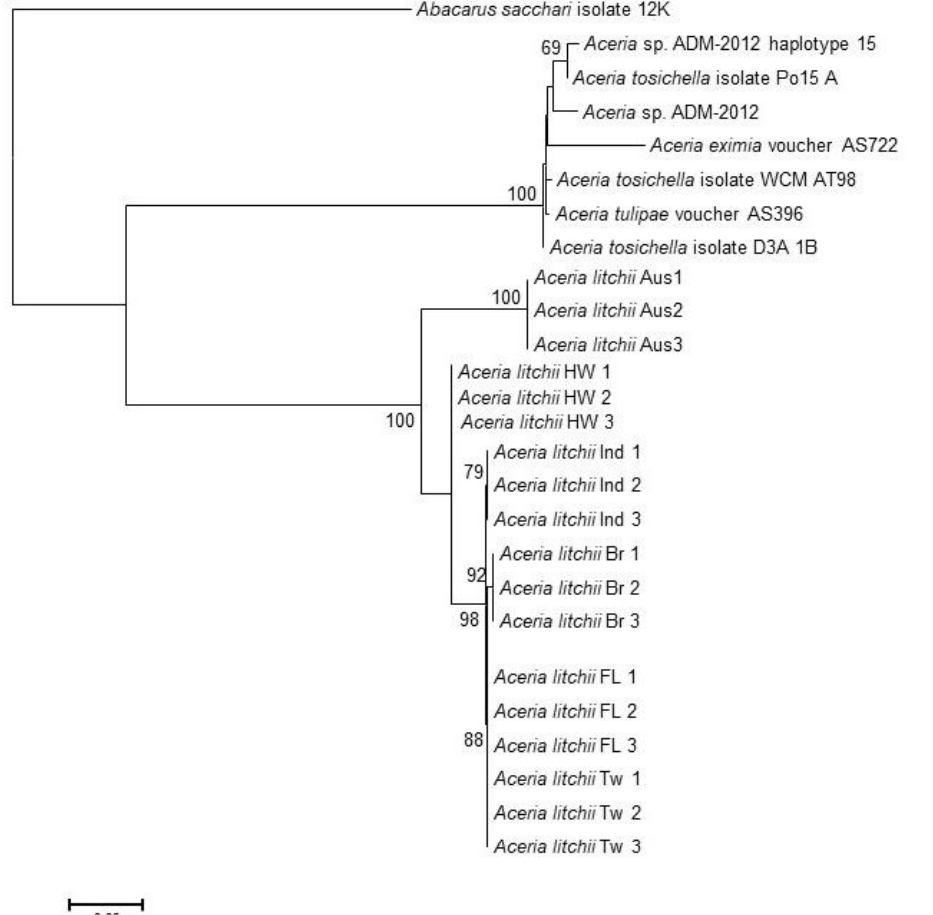
Figure 4. Phylogeny of Aceria species as inferred by Maximum Likelihood of the ITS1 and ITS2 concatenated sequences. Numbers presented above and below each node indicate maximum likelihood bootstrap values and Bayesian a posteriori probability for the corresponding inner branch. Table 2. Sequence diversity estimates for A. litchii.